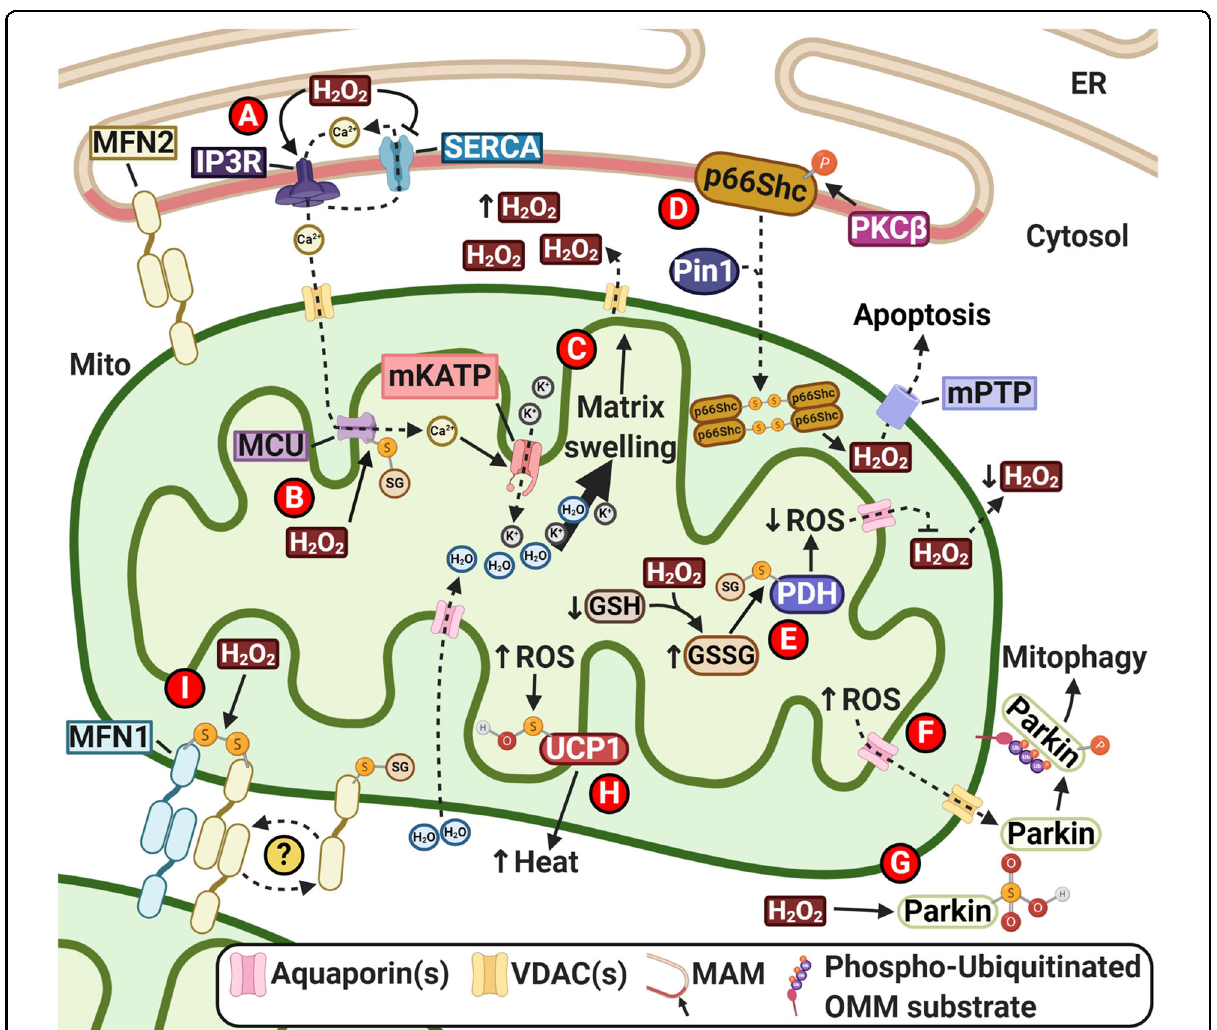
Fig. 3 Known redox signaling pathways regulated by mitochondrial hydrogen peroxide (mtH 2 O 2 ). A Calcium (Ca 2 + ) signaling communicated between the endoplasmic reticulum (ER) and the mitochondria (Mito) via the inositol 1,4,5-trisphosphate receptor (IP3R), sarco-/endoplasmic reticulum Ca 2 + -ATPase (SERCA) Ca 2 + channels, and the voltage-dependent anion channel (VDAC); MAM: Mitochondria-associated membrane. B Ca 2 + uptake by mitochondrial calcium uniport (MCU) after S-glutathionylation of Cys97. C mtH 2 O 2 ef fl ux from mitochondrial matrix swelling and reduced intermembrane space. D Cell death induced by the opening of the mitochondrial permeability transition pore (mPTP) via the tetramerization of p66Shc; PKC β : Protein Kinase C β ; Pin1: Prolyl Isomerase 1. E Increasing oxidized glutathione (GSSG) to reduced glutathione (GSH) ratio could reduce mtROS production by pyruvate dehydrogenase (PDH) and reduce the release of mtH 2 O 2 . F Parkin-dependent mitophagy mediated by mtROS; OMM: Outer mitochondrial membrane. G Increased levels of cellular ROS have been known to cause Parkin sul fi nylation and inhibition by intracellular H 2 O 2 . H Increased heat production by sulfenylated uncoupler protein 1 (UCP1) during hypothermia. I Activation of mitofusion from the disul fi de bond formation of mitofusin 1 (MFN1) and mitofusin 2 (MFN2). This disul fi de bond formation could further S-glutathionate MNF2 to activate mitofusion. Created with